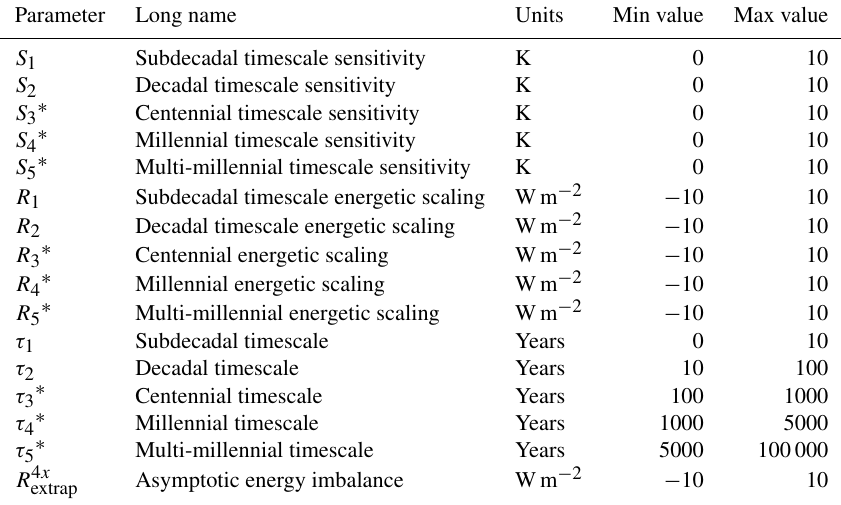
Table 2. Parameters and prior ranges considered in the Bayesian calibration of Eq. (1a). Parameters marked ∗ are optionally included according to the model under consideration (see Table